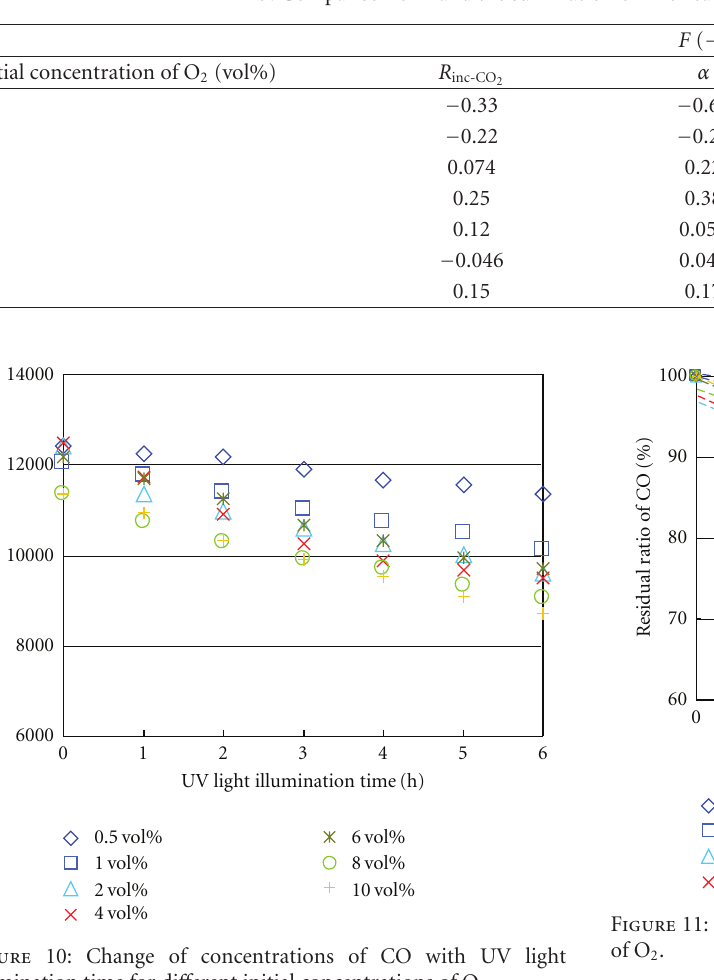
Table 3: Comparison of F and the summation of F for each initial concentration of O 2 .